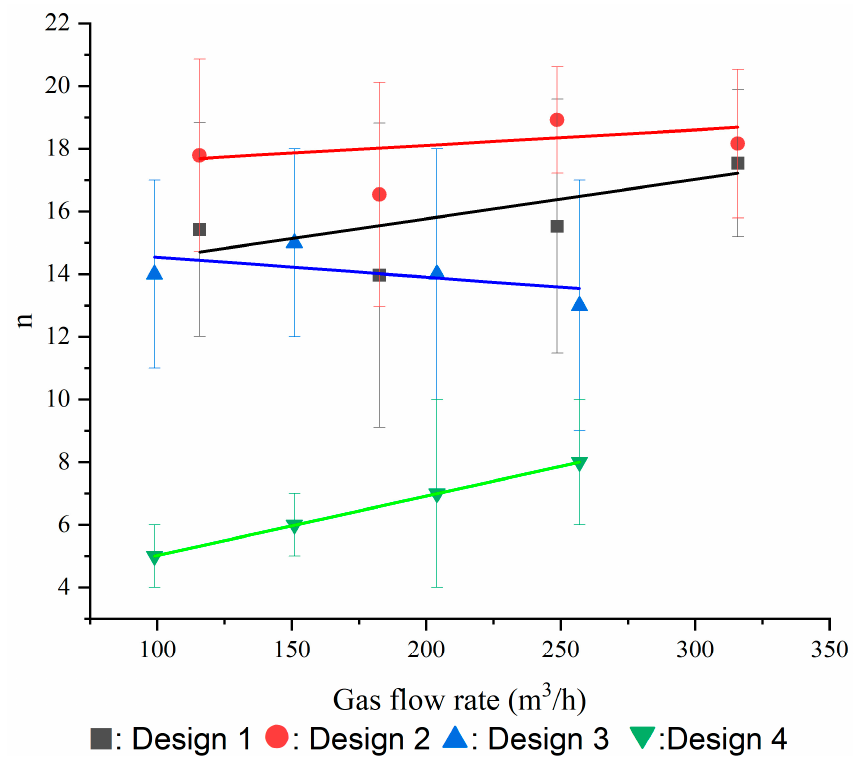
Figure 7. Number of equivalent CSTR in series ( n ) for different configurations and gas flow rates.